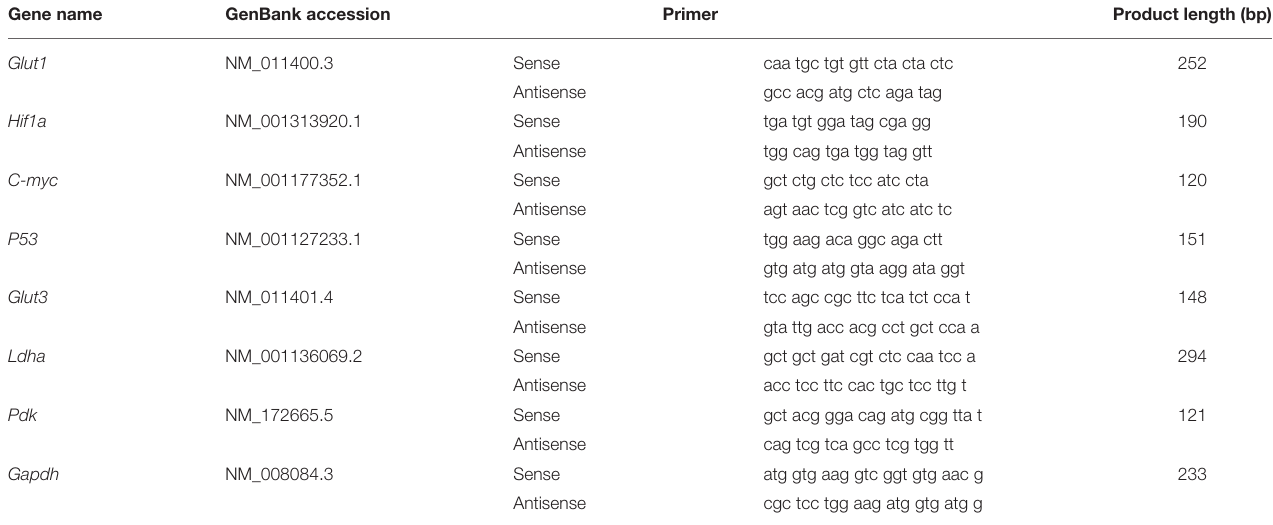
TABLE 1 | Primers for quantitative real-time